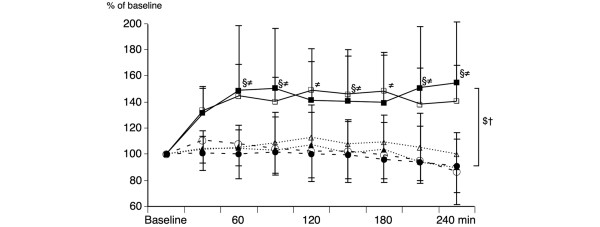
Relative changes in intestinal microcirculation and tissue oxygen tension (ptiO2). Black squares indicate relative changes in microcirculatory blood flow (MBF) in the goal-directed colloid fluid therapy (GD-C) group. Open squares indicate relative changes in ptiO2 in the GD-C group. Black triangles indicate relative changes in MBF in the goal-directed Ringer lactate fluid therapy (GD-RL) group. Open triangles indicate relative changes in ptiO2 in the GD-RL group. Black circles indicate relative changes in MBF in the restricted Ringer lactate fluid therapy (R-RL) group. Open circles indicate relative changes in ptiO2 in the R-RL group. The R-RL group received 3 mL/kg per hour of lactated Ringer solution throughout the entire experiment. The GD-RL group received 3 mL/kg per hour of lactated Ringer solution plus 250 mL of lactated Ringer solution if mixed venous oxygen saturation (SvO2) was less than 60%. The GD-C group received 3 mL/kg per hour of lactated Ringer solution plus 250 mL of hydroxyethyl starch (130/0.4) if SvO2 was less than 60%. Baseline was set at 100% for all parameters. Significant differences (P < 0.05) for area under the curve: †R-RL versus GD-C, $GD-RL versus GD-C. Significant differences (P < 0.05) for analysis of variance for repeated measurements (Tukey post hoc test): ≠R-RL versus GD-C, §GD-RL versus GD-C.